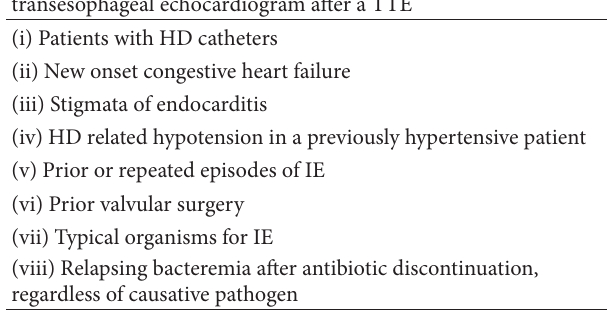
Table 1: High suspicion features mandating TTE in patients with HD and suspected